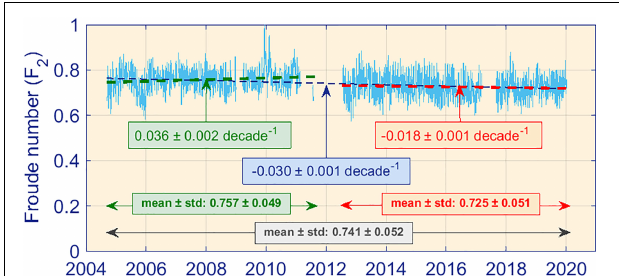
FIGURE 7 | Time evolution of the lower layer Froude number ( F 2 ) computed according to equation [4]. Dashed blue line is the linear trend for the whole series and dashed green and red lines show the trends before and after the gap of year 2012, respectively. All numerical values, including 95% confidence levels, are indicated inside the text-boxes with the same color code. Mean and standard deviation for the whole series, and for the first and second parts are also indicated.